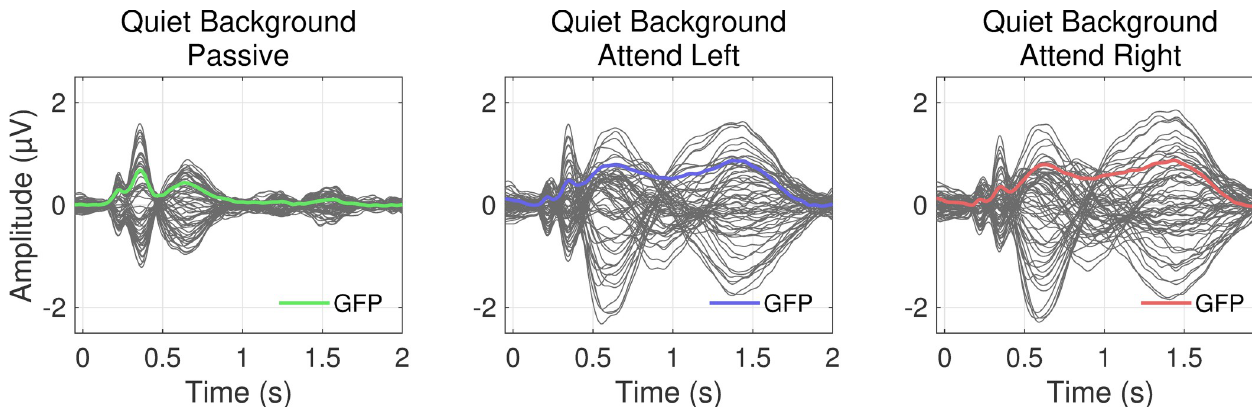
Fig 2. Average potentials measured at the scalp for three attention conditions (Passive, Attend Left, and Attend Right) in quiet background. Dark grey lines represent 64 recording sites, and colored lines are the baseline-corrected global field power (GFP) across all electrodes.